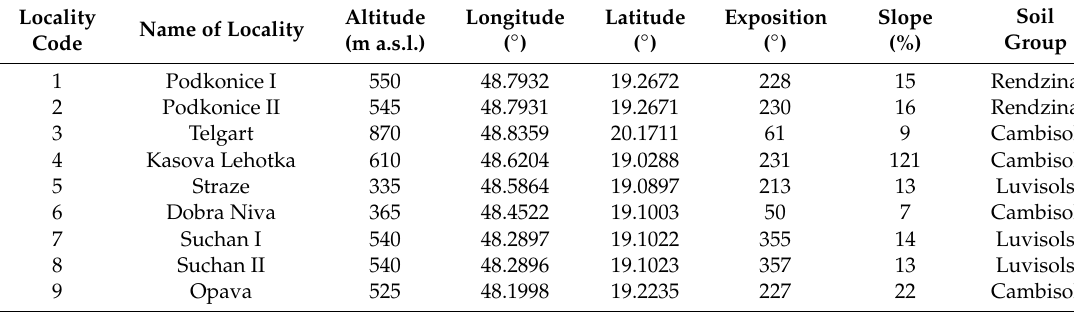
Table 1. Site characteristics of the forest stands selected for common aspen sampling and measurements. Locality Altitude Longitude Latitude Name of Locality